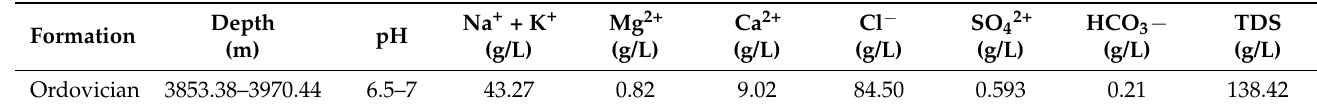
Table 2. Hydro-chemical characteristics of the formation water